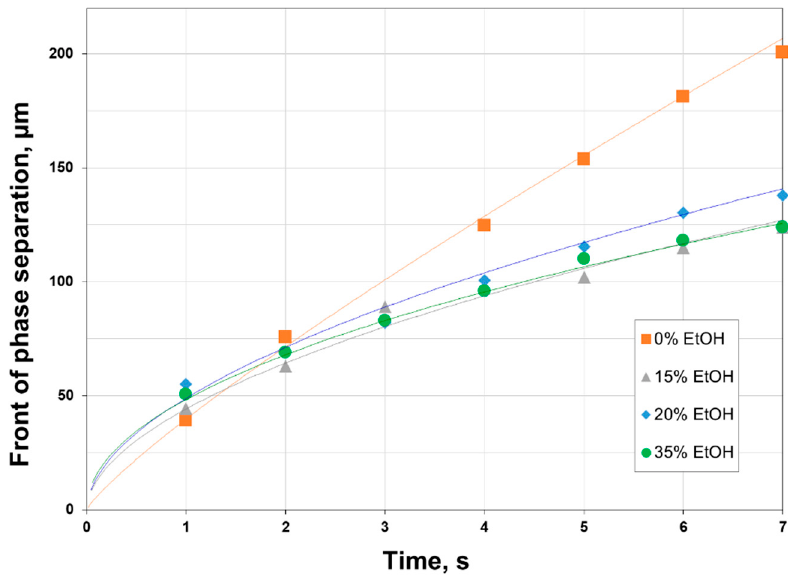
Figure 8. Change of the phase separation front as a function of time (the trend lines are provided as eye-guidance).